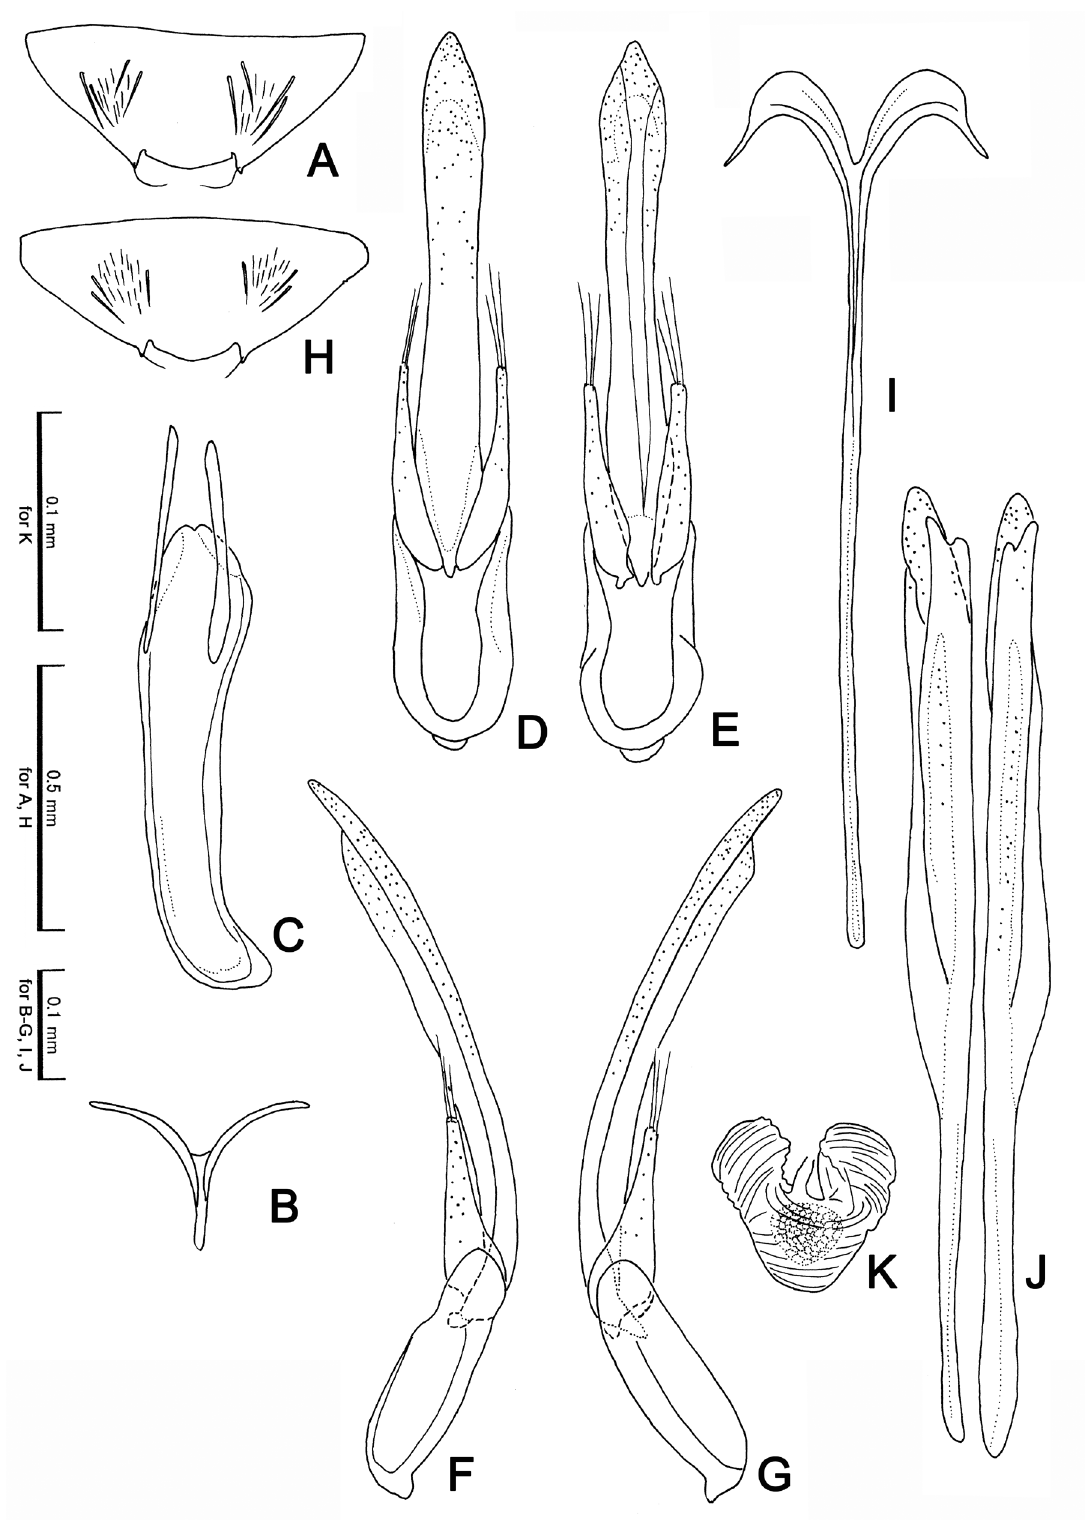
Fig. 13. Mexico baliensis sp. nov., male (A–G) and female (H–K) genitalia (paratypes, EUMJ). A, H . Sternite VII. B . Sternite VIII. C . Sternite IX. D . Aedeagus in dorsal view. E . Aedeagus, ventral view. F . Aedeagus in right lateral view. G . Aedeagus, left lateral view. I . Urosternite. J . Ovipositor. K .